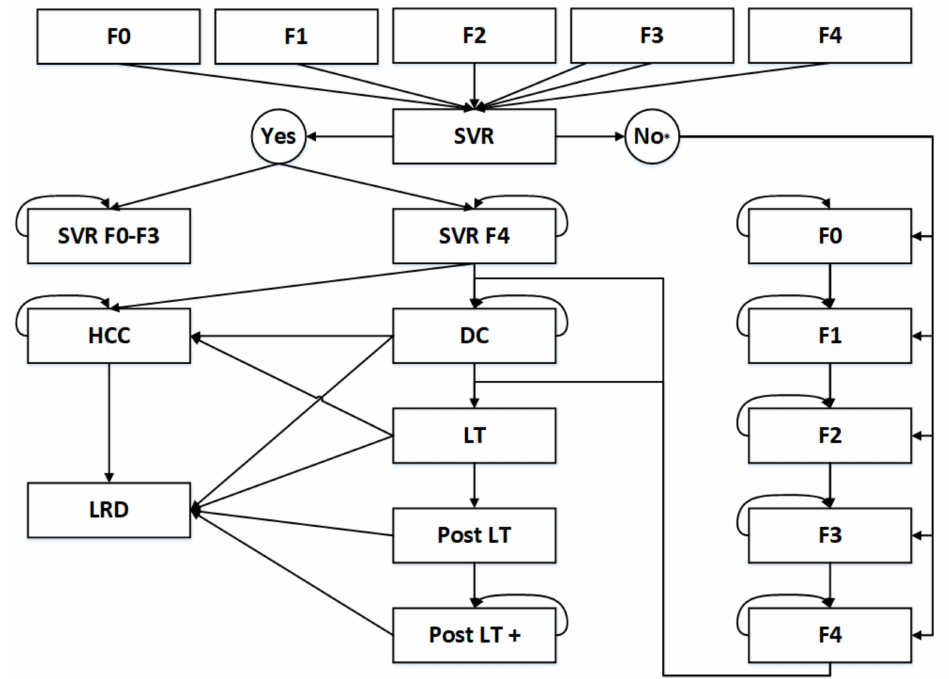
Figure 1. Markov model for hepatitis C virus (HCV). METAVIR score: F0, F1, F2, F3, F4; SVR: Sustained Virologic Response; HCC: hepatocellular carcinoma; DC: decompensated cirrhosis; LT: liver transplantation; LRD: liver-related death. * In case of treatment failure, patients will be in the same METAVIR state after the